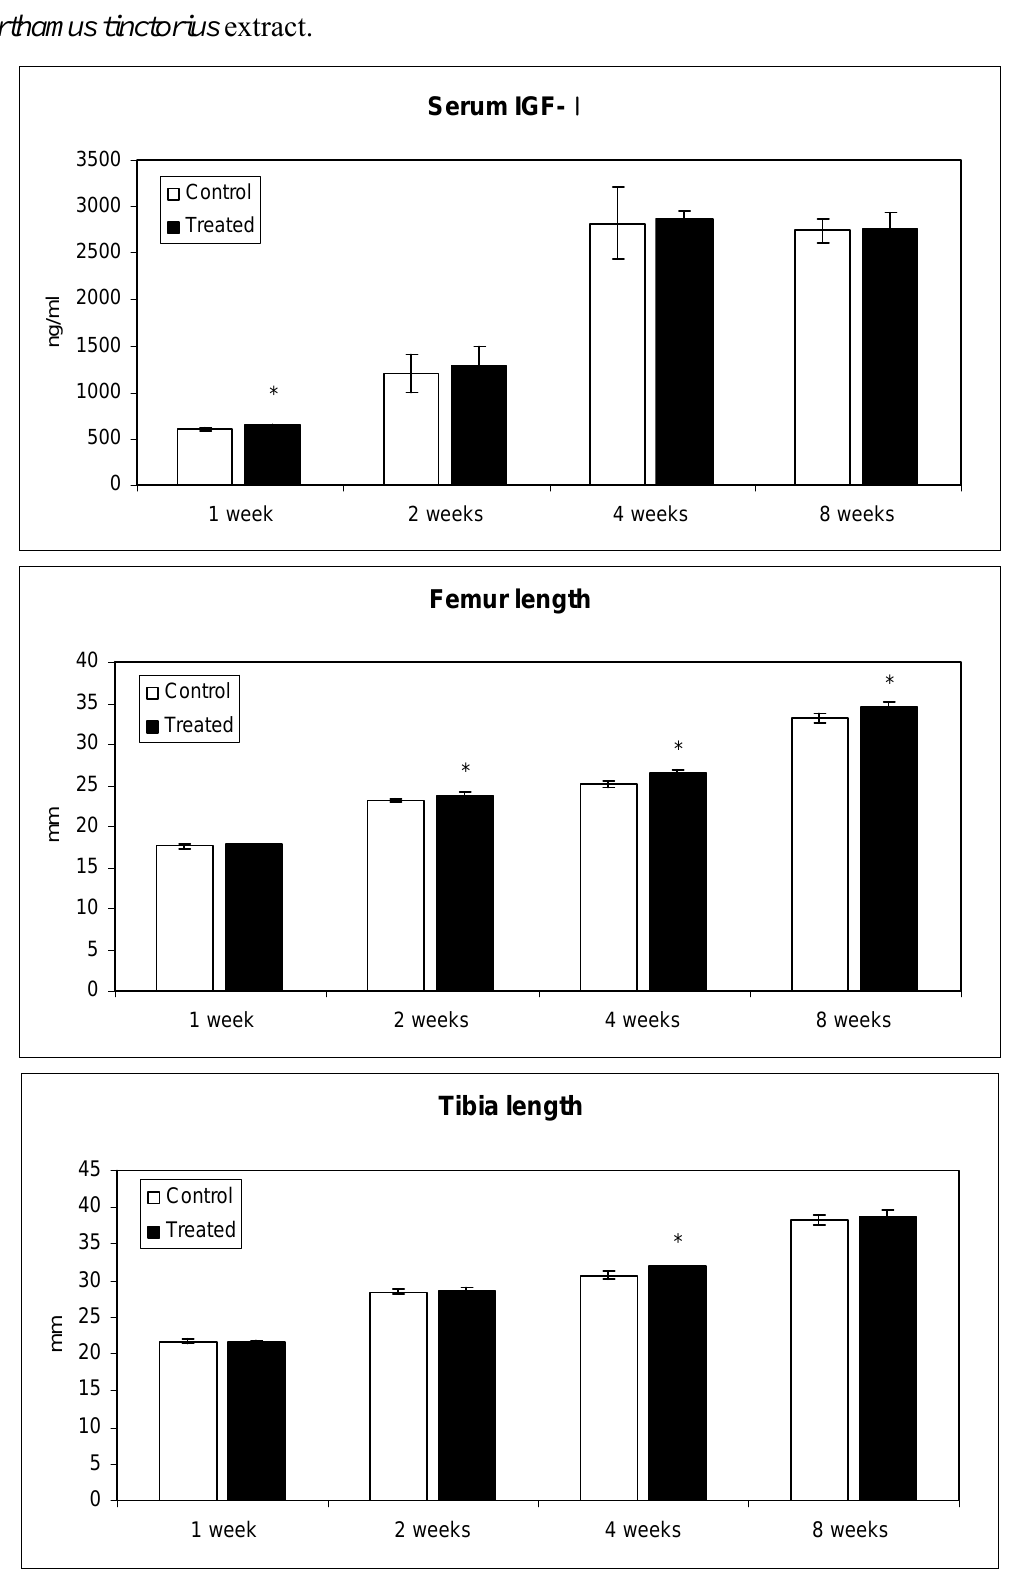
Values are mean ± S.E. *Statistically significant difference between experimental and control group by Student's t-test at 0.05. C: control group and T: administration of Carthamus tinctorius was started at age of 3 weeks